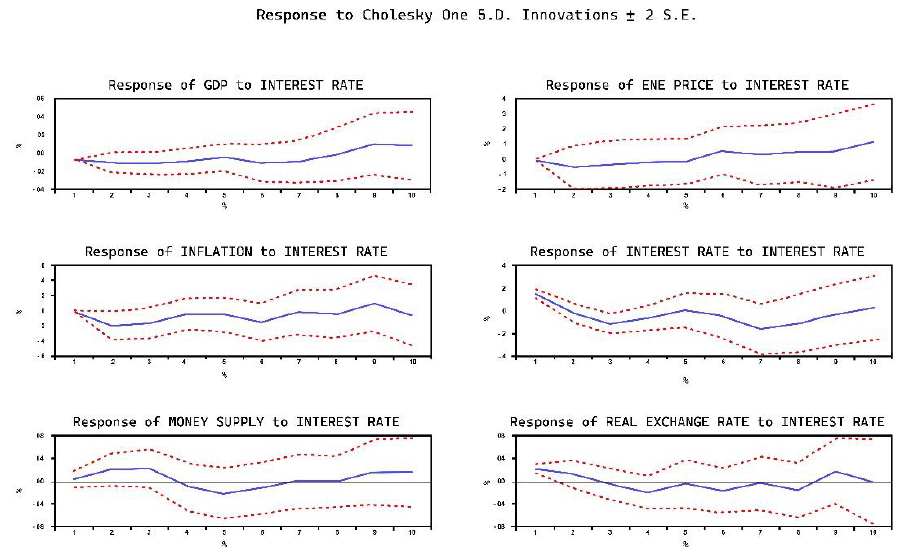
Figure 8. VAR impulse response to interest rate (VAR IRF with intercept using annual data for 1980 – 2022).